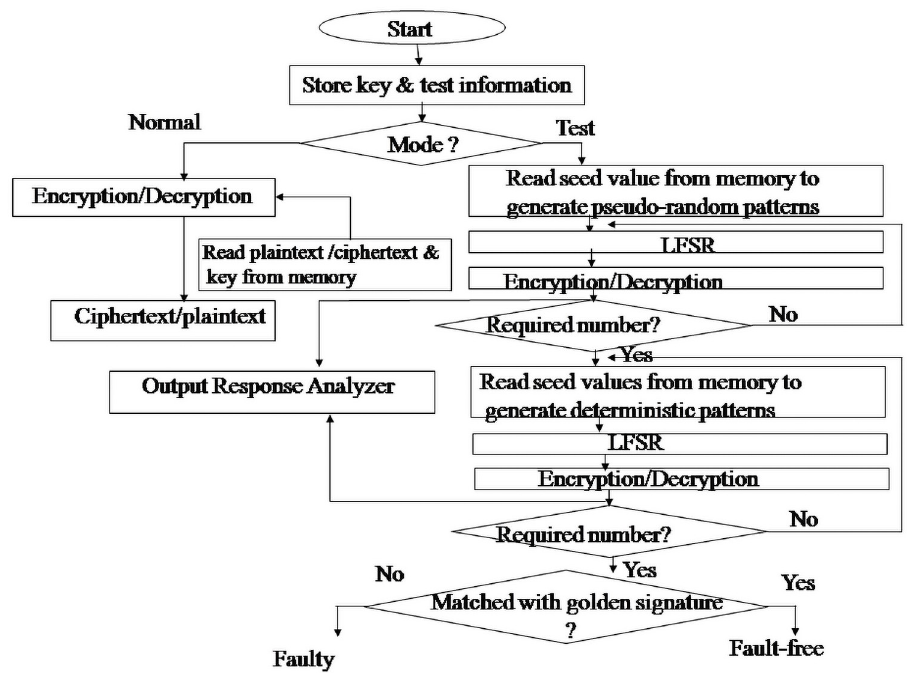
Fig 4. Flowchart of the AES Crypto ASIC with